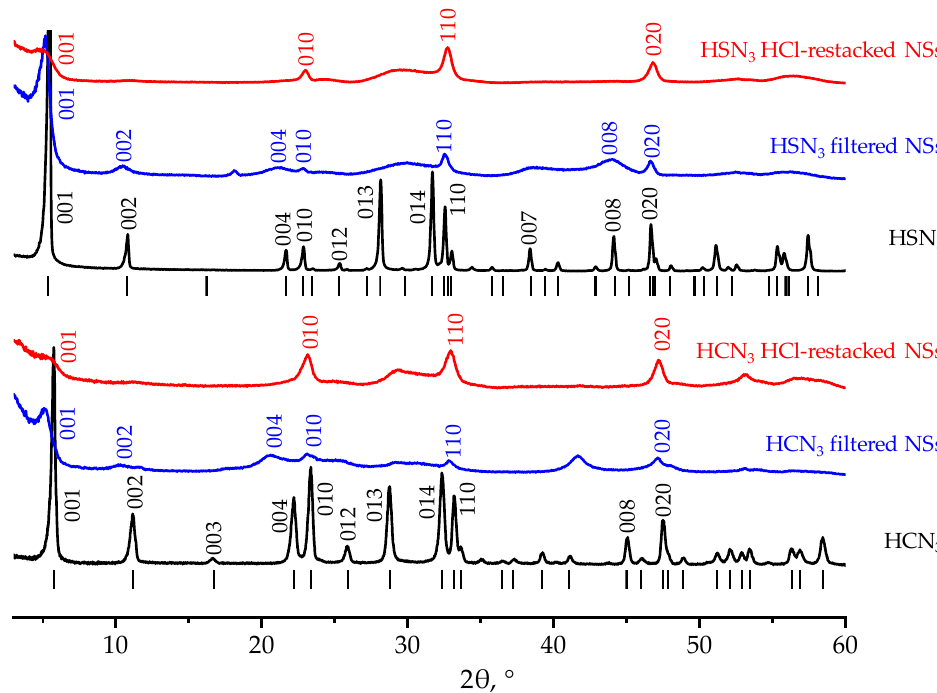
Figure 1. Powder XRD patterns of the protonated niobates and their reassembled nanosheets. Table 1. Lattice parameters in the tetragonal system, interlayer distances, light absorption edges, specific surface areas of the protonated niobates and their reassembled nanosheets as well as hy- drodynamic radii and ζ -potentials of the pristine nanosheets in suspensions before reassembly.